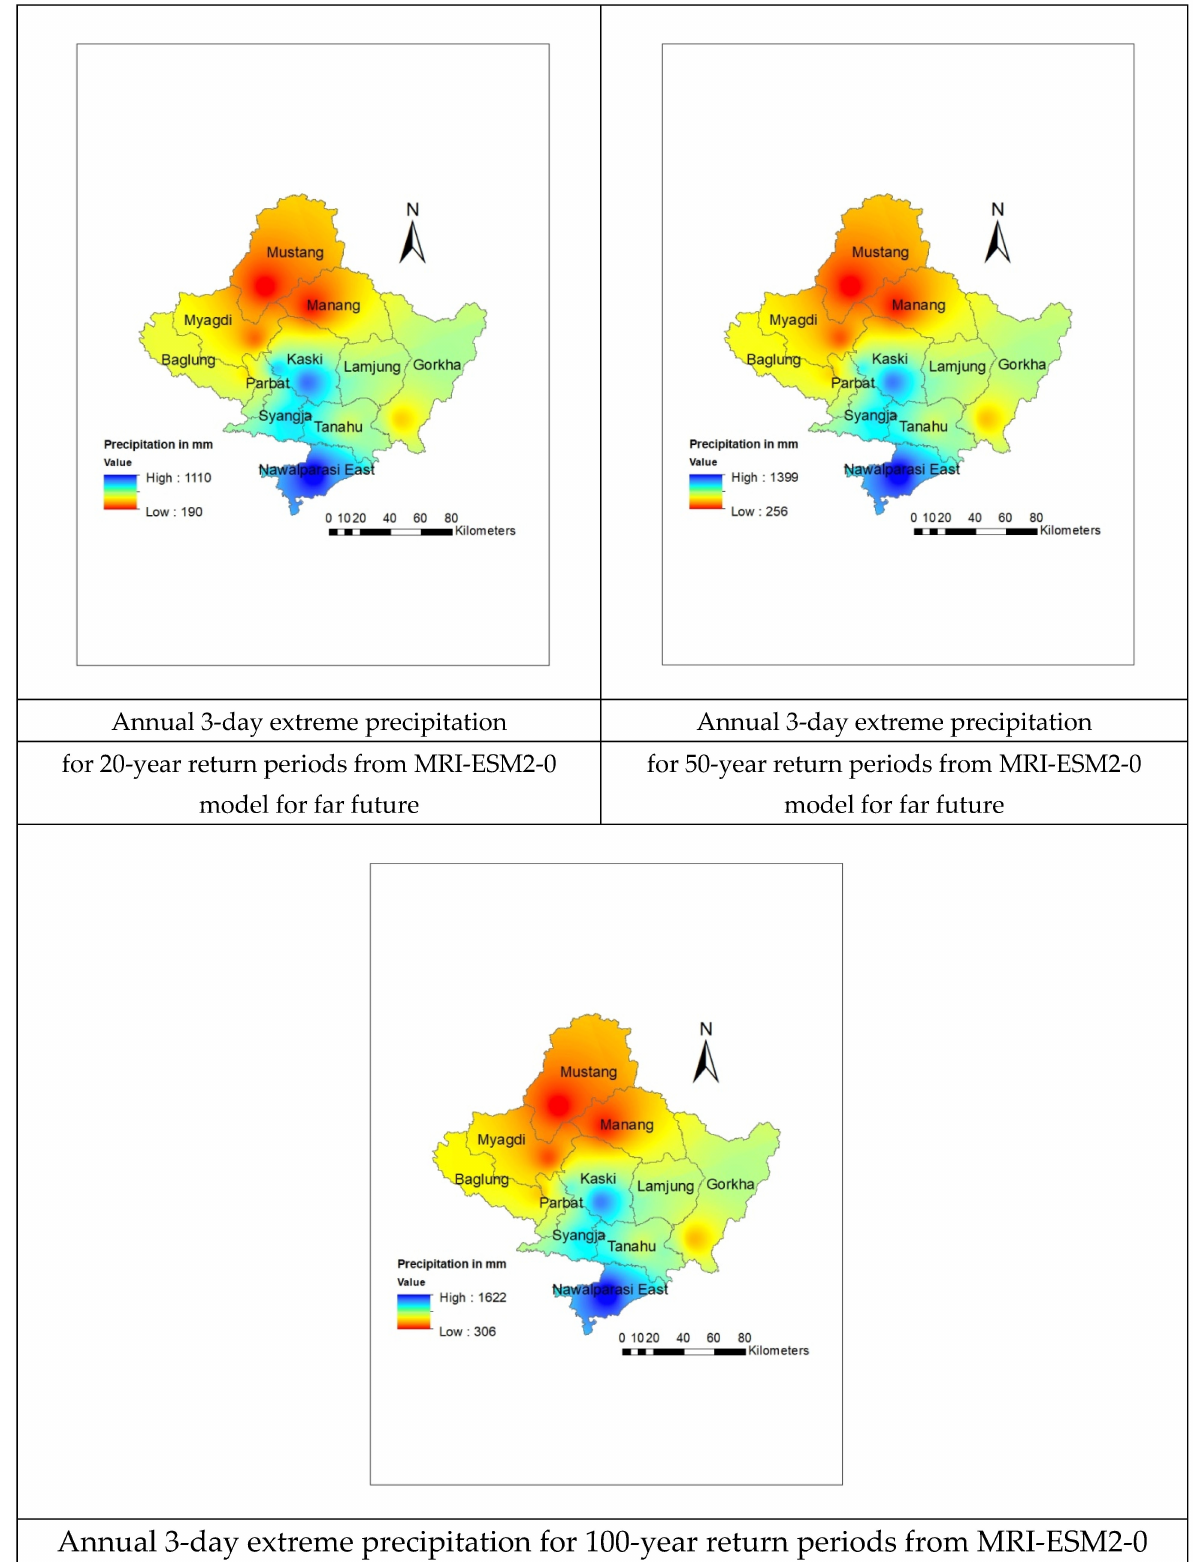
Figure A16. Projected spatial annual 3-day extreme